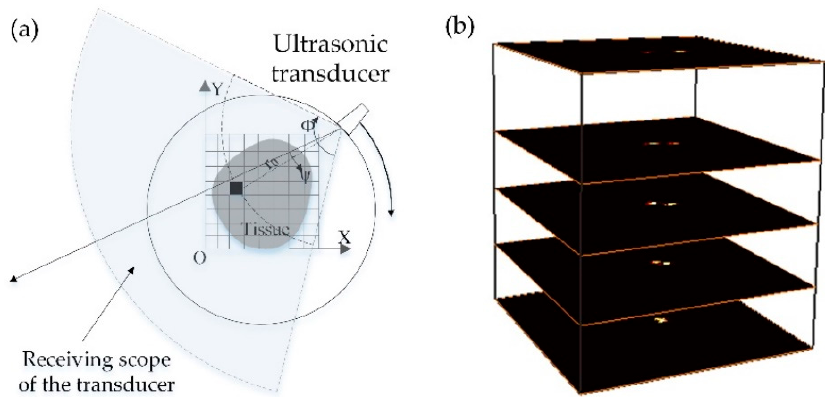
Figure 3. ( a ) A 2D schematic of the improved back-projection reconstruction algorithm, and ( b ) 3D photoacoustic image reconstruction.